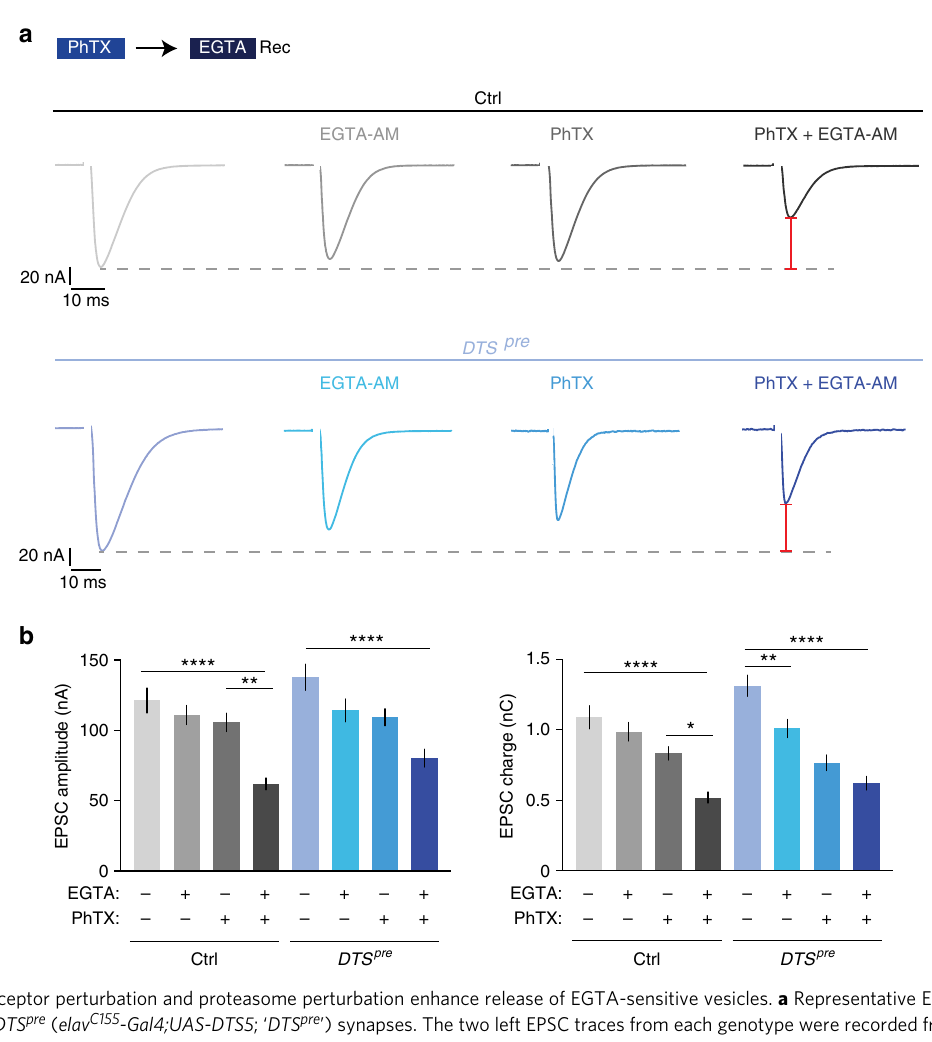
corresponding changes in Alexa-568- fl uorescence intensity (Fig. 6d, left), suggesting that presynaptic proteasome impairment elevates baseline Ca 2+ levels. Ca 2+ -transient decay kinetics were similar between mutant and control synapses, indicating that DTS expression does not alter Ca 2+ extrusion and/or Ca 2+ buffering (Fig. 6d, right). Together, these data demonstrate that presy- naptic proteasome perturbation results in increased presynaptic Ca 2+ in fl ux upon AP stimulation, as well as elevated Ca 2+ levels at rest. This indicates that presynaptic proteasome function nega- tively regulates presynaptic Ca 2+ signaling under baseline conditions.